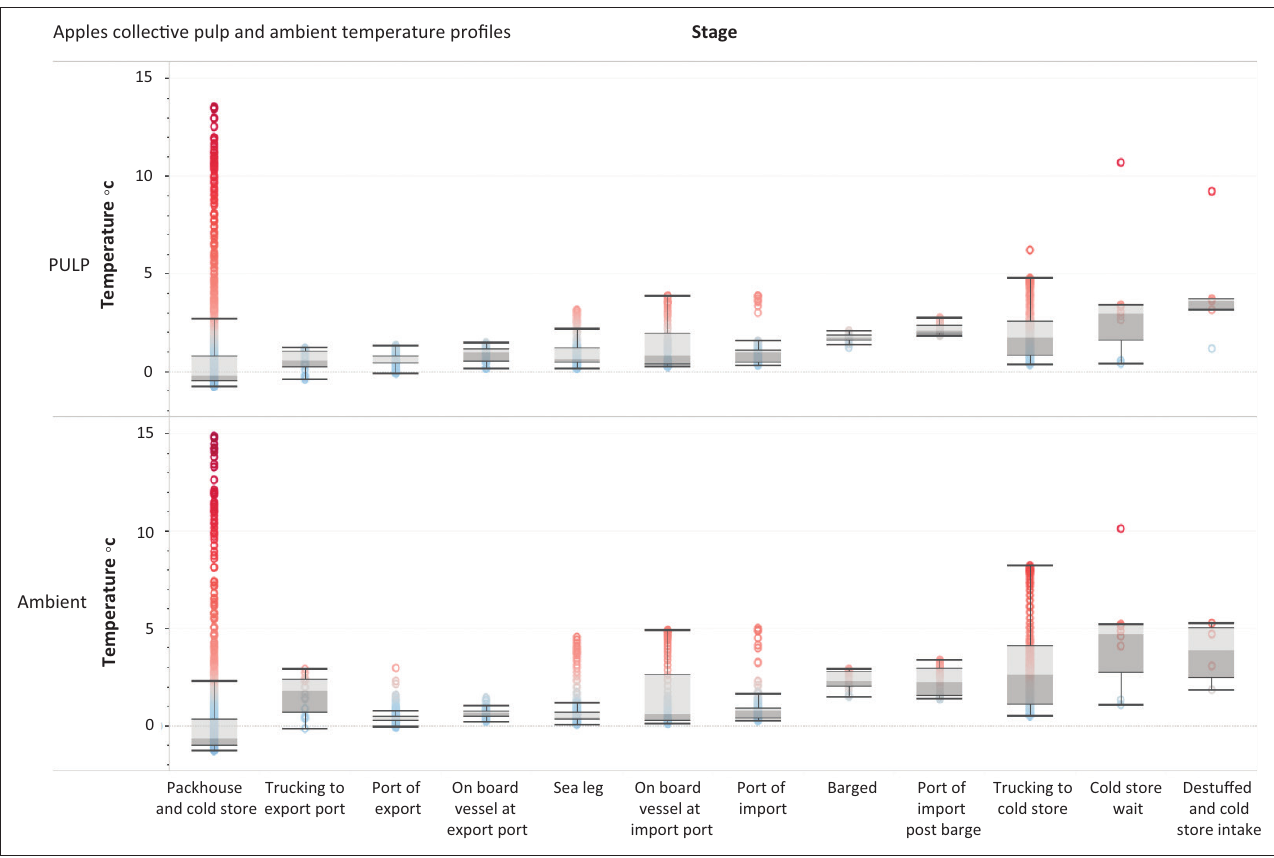
FIGURE 5: Apples trials collective temperature profiles box and whisker